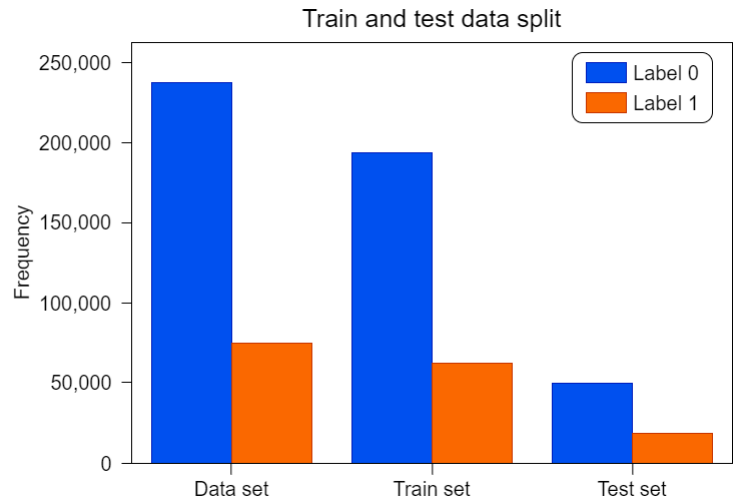
Figure 5. Training and test samples